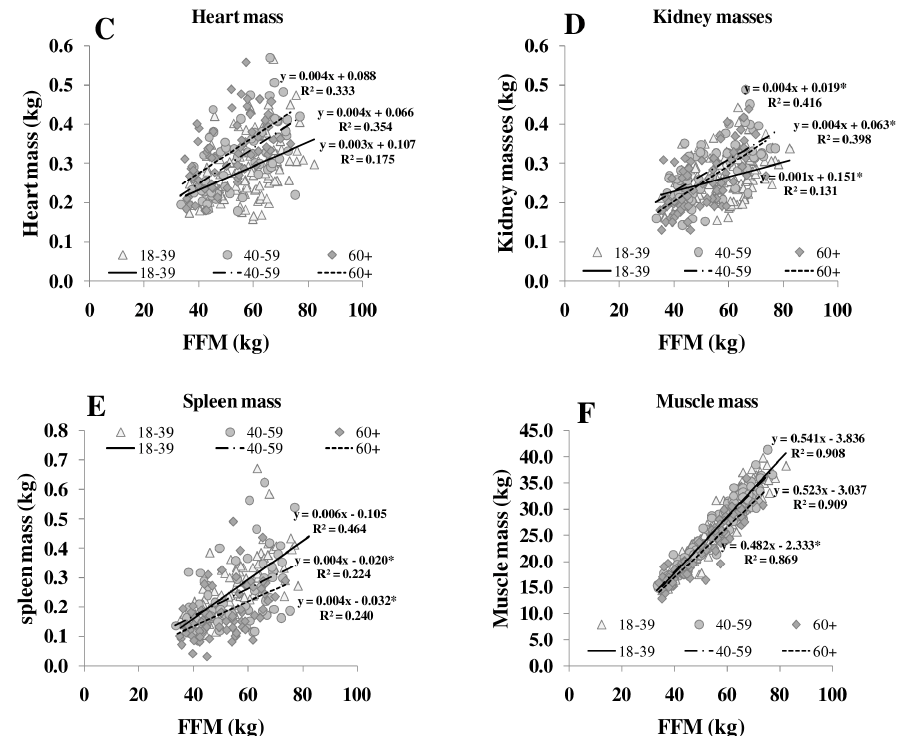
Figure 3. Relationships between FFM and masses of brain ( A ), liver ( B ), heart ( C ), kidneys ( D ), spleen ( E ) and skeletal muscle ( F ) in different age groups. FFM was assessed by ADP, organ masses were assessed by whole body MRI ( n = 369). * significant difference between youngest and other age groups ( p < 0.05).